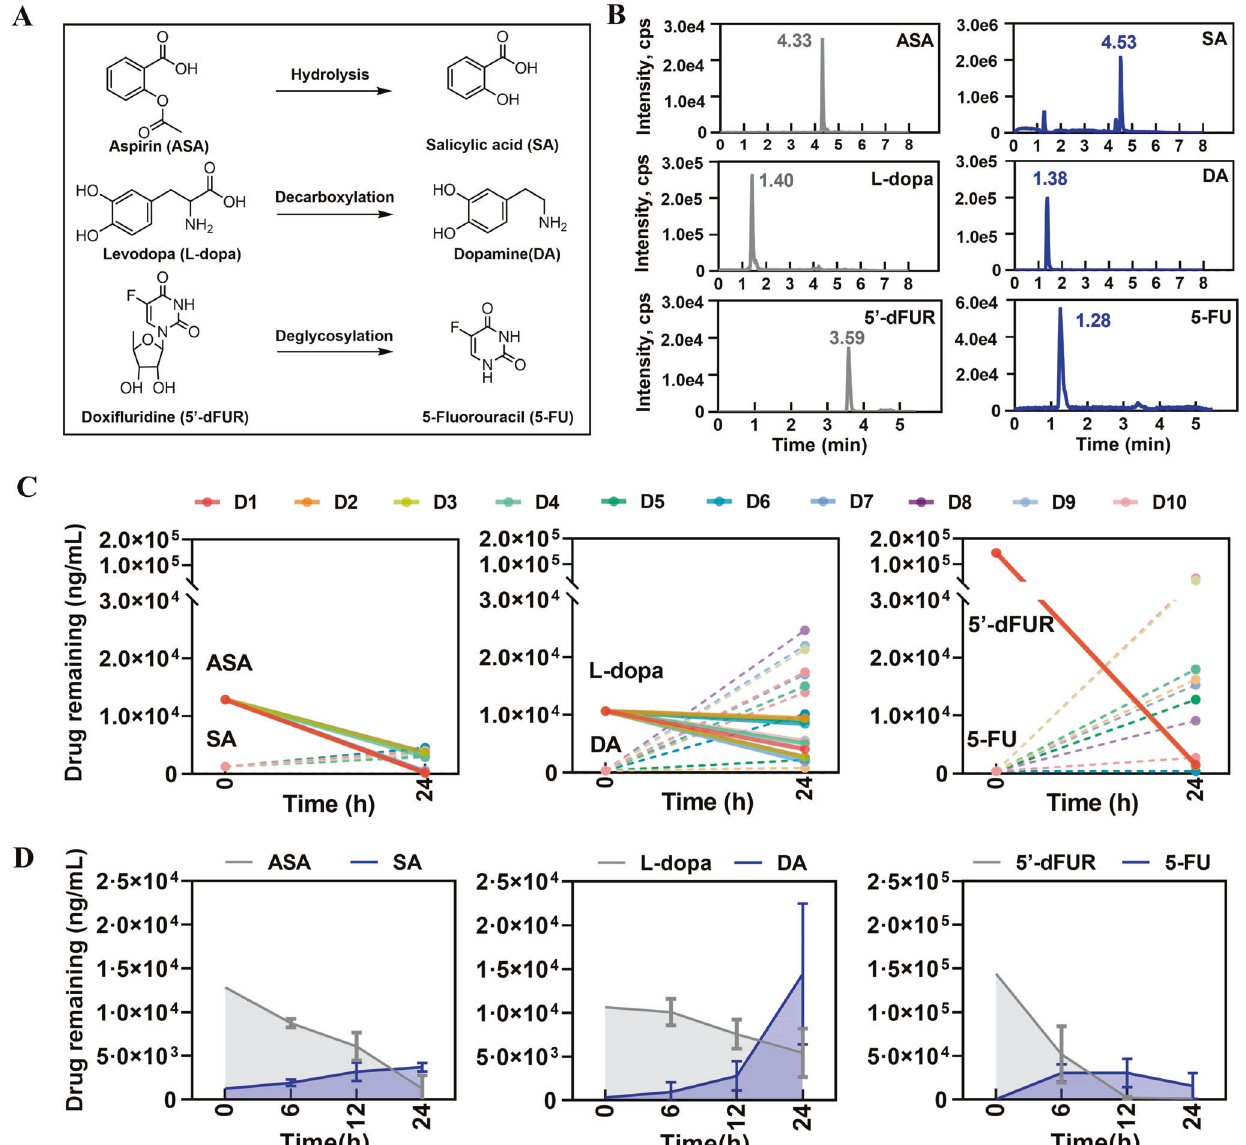
Fig. 6 Personalized drug metabolism by human gut microbiota ex vivo. A Metabolism of ASA, L-dopa and 5 ′ -dFUR. B The chromatograms of ASA, SA, L-dopa, DA, 5 ′ -dFUR and 5-FU. C Drug remaining after incubation with gut microbiota on 24 h for each donor-drug combination. D Drug remaining after incubation with gut microbiota on 6, 12, and 24